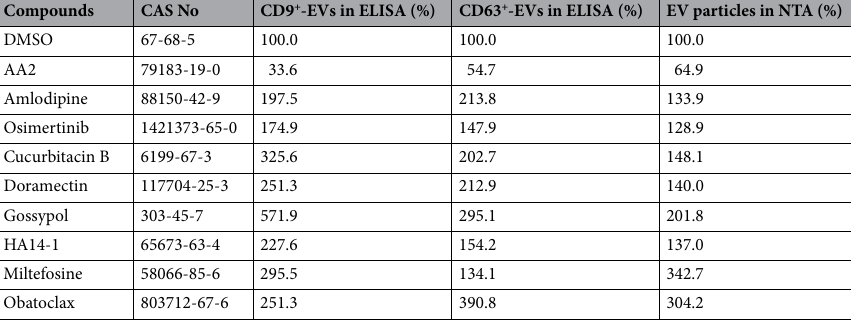
Table 1. Activity of EV regulators in U87MG